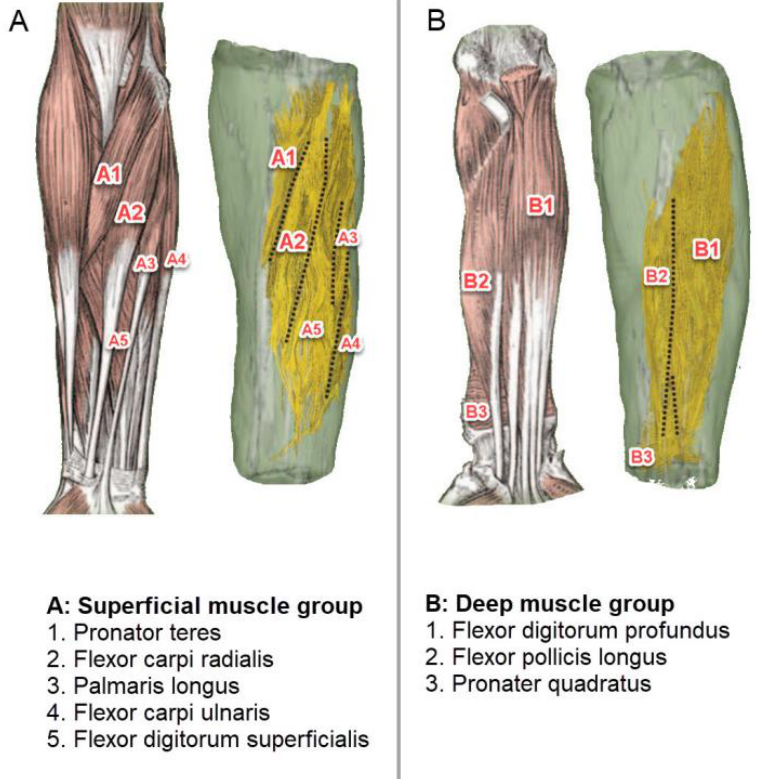
Figure 4. Illustration of fiber tractography and textbook anatomical structure of main forearm flexor muscles [62]. ( A ) Superficial muscle groups of a forearm. ( B ) Deep muscle group of a forearm.